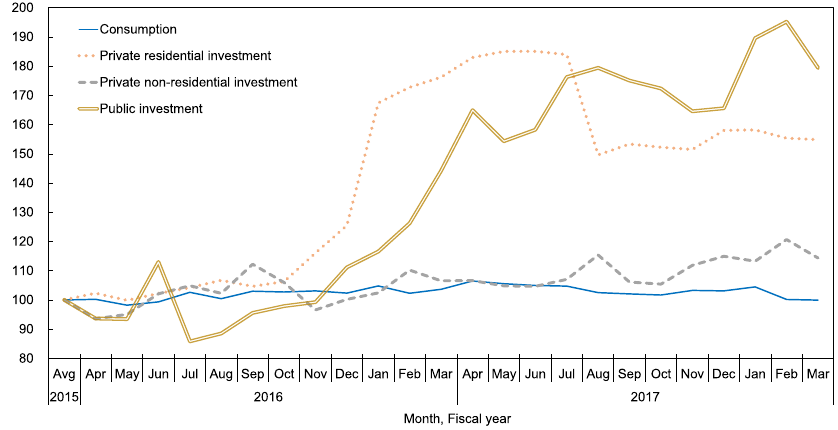
Fig. 2 Regional Domestic Expenditure Index. Source: Based on the Regional Domestic Expenditures